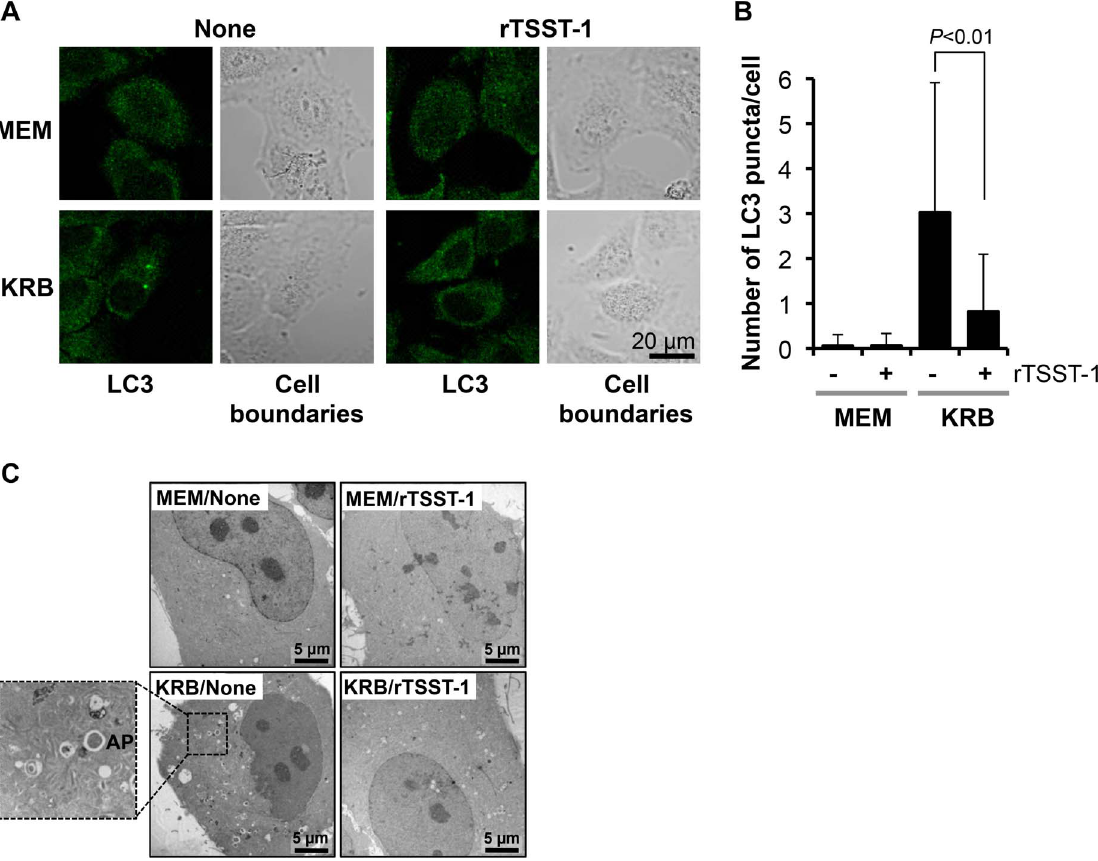
Figure 4. Suppression of autophagy by rTSST-1 is observed by immunostaining and electron microscopy. Autophagy in HeLa 229 cells was observed in nutrient-rich (MEM) or nutrient-starvation (KRB) condition containing lysosomal protease inhibitors with or without the addition of 10 m g/ml rTSST-1. At 4 h, the cells were fixed and washed. (A) Autophagosomes were stained with anti-LC3 antibody and rhodamine-conjugated anti-rabbit IgG, and then observed under confocal microscope. (B) LC3 puncta were counted from 100 cells of 3 independent-experiments. (C) Autophagosomes were observed under electron microscope. AP indicates autophagosome-like vacuole.